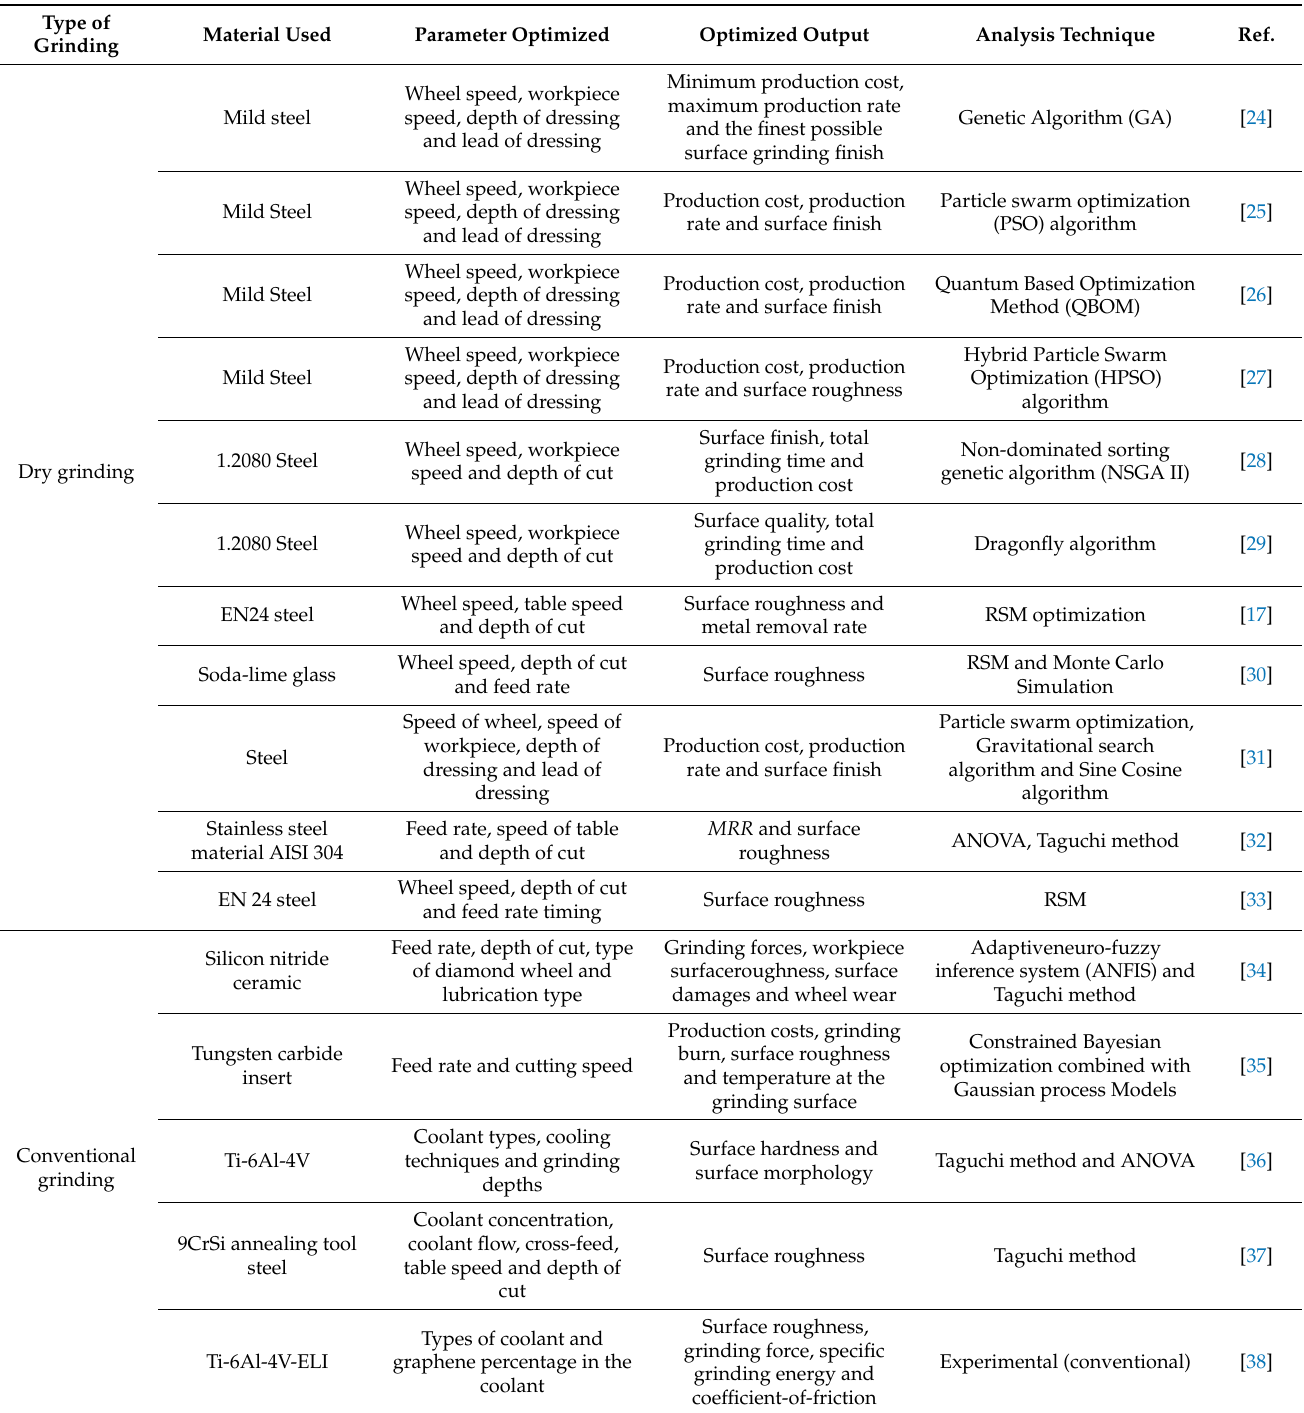
Table 1. Grinding process parameters optimization using different analysis techniques in the